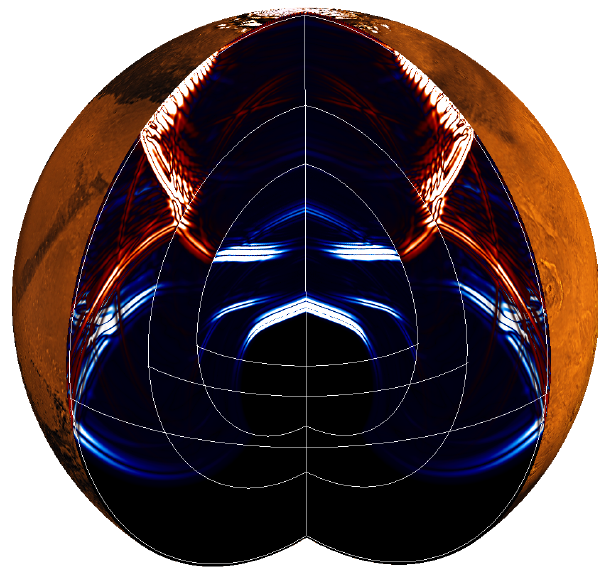
Figure 22. Seismic waves traveling in Mars after a meteorite impact at its north pole computed with AxiSEM. P-waves are shown in blue and S-waves and surface waves in